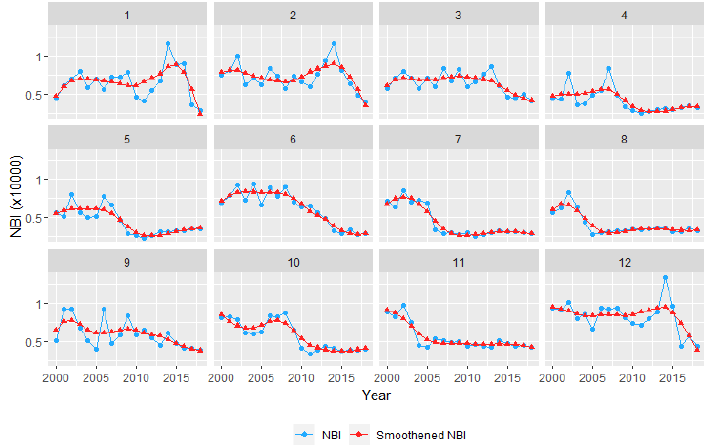
Figure 4. Time series of yearly 80th percentile normalized difference vegetation index (NDVI) in 12 points in the study region that show transition to urban areas. The final dip in NDVI value, which does not rise again, can be observed and inferred to as the point in which the land cover transitioned in all the points.